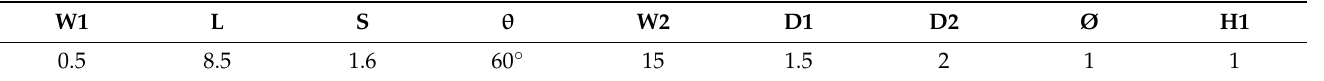
Table 1. Sensor structure parameter table.